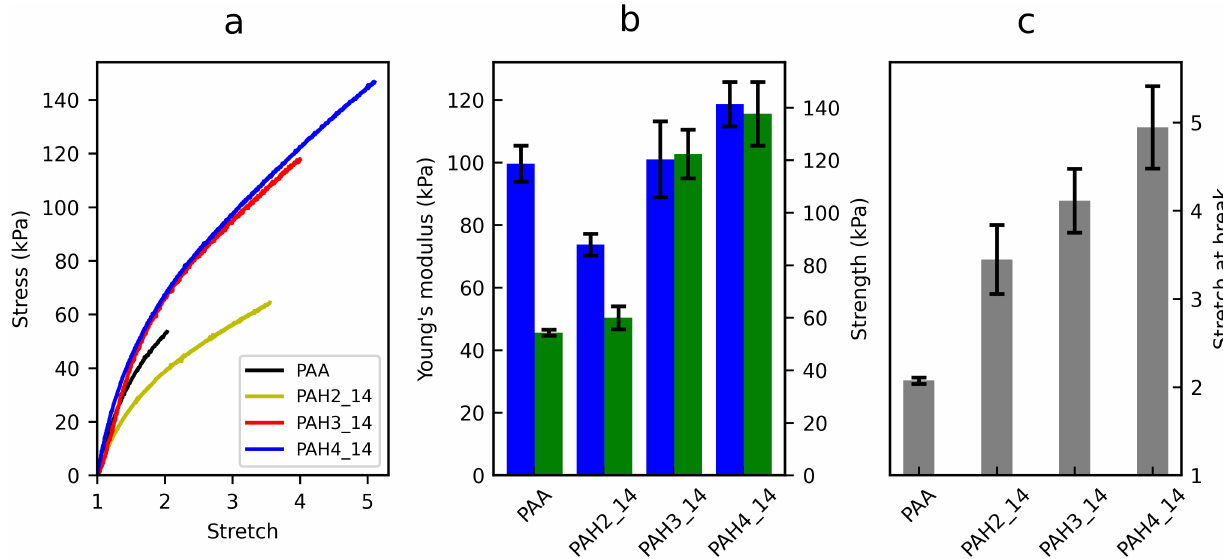
Figure 6. Mechanical behaviour of PAA hydrogels with and without adding HBPs, in uniaxial tension. Effects of varying the HBP generation were explored. ( a ) Typical nominal stress–stretch curves. ( b ) Young’s modulus and tensile strength. ( c ) Stretch at break. Error bars show the standard derivation (SD); sample size, n = 3 per